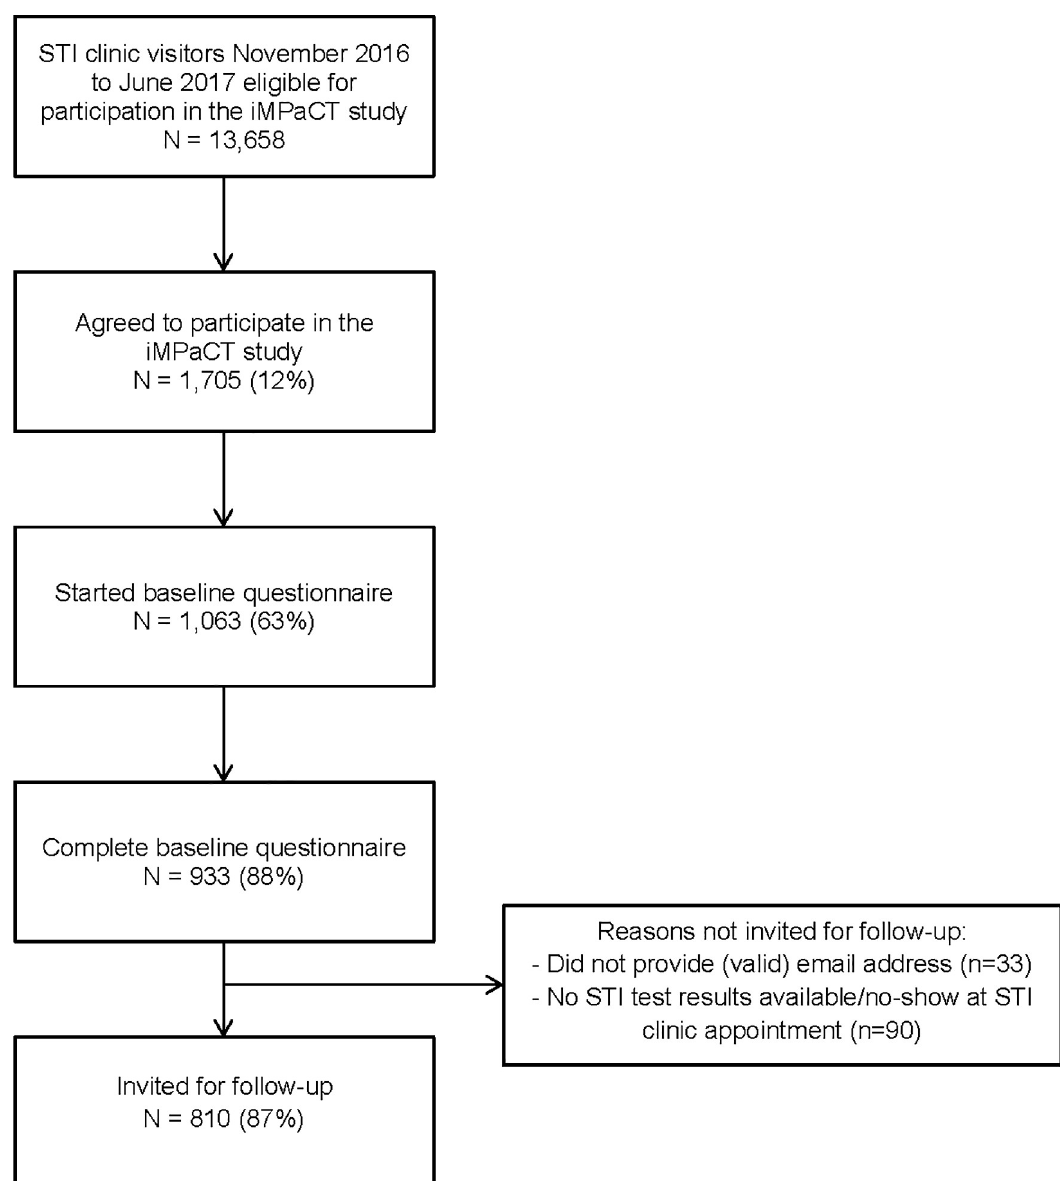
Fig 1. Baseline response rates in the iMPaCT study. Abbreviations: STI = Sexually Transmitted